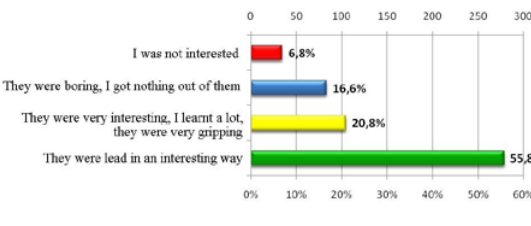
Figure 1. Students reviews for First Aid classes